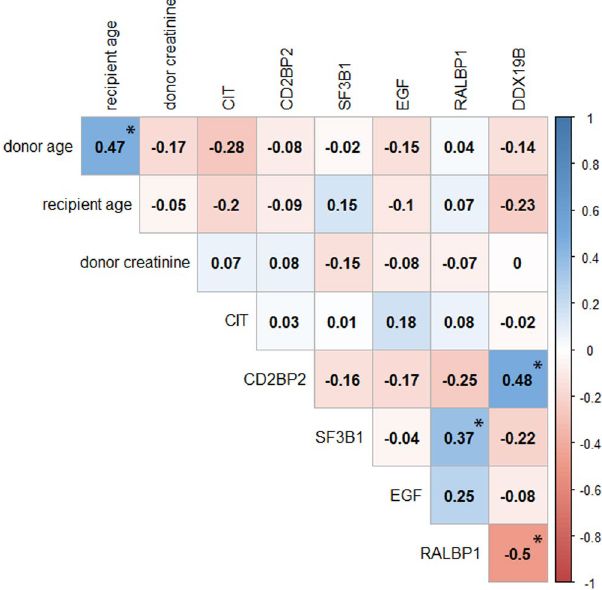
Figure 2. Correlation plot of continuous predictor variables. Pairwise Pearson correlations are displayed with positive and negative correlations indicated by blue and red shaded areas respectively. Significant correlations after Bonferroni correction for multiple testing are indicated by asterisks. CIT = cold ischemia